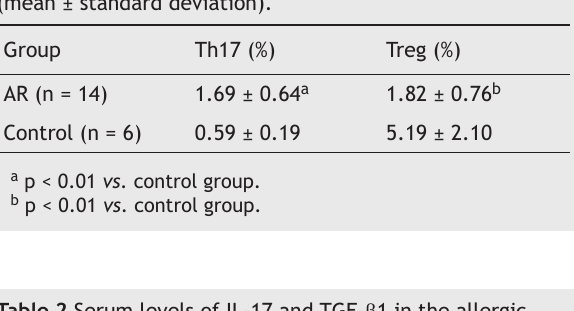
Table 2 Serum levels of IL-17 and TGF- β 1 in the